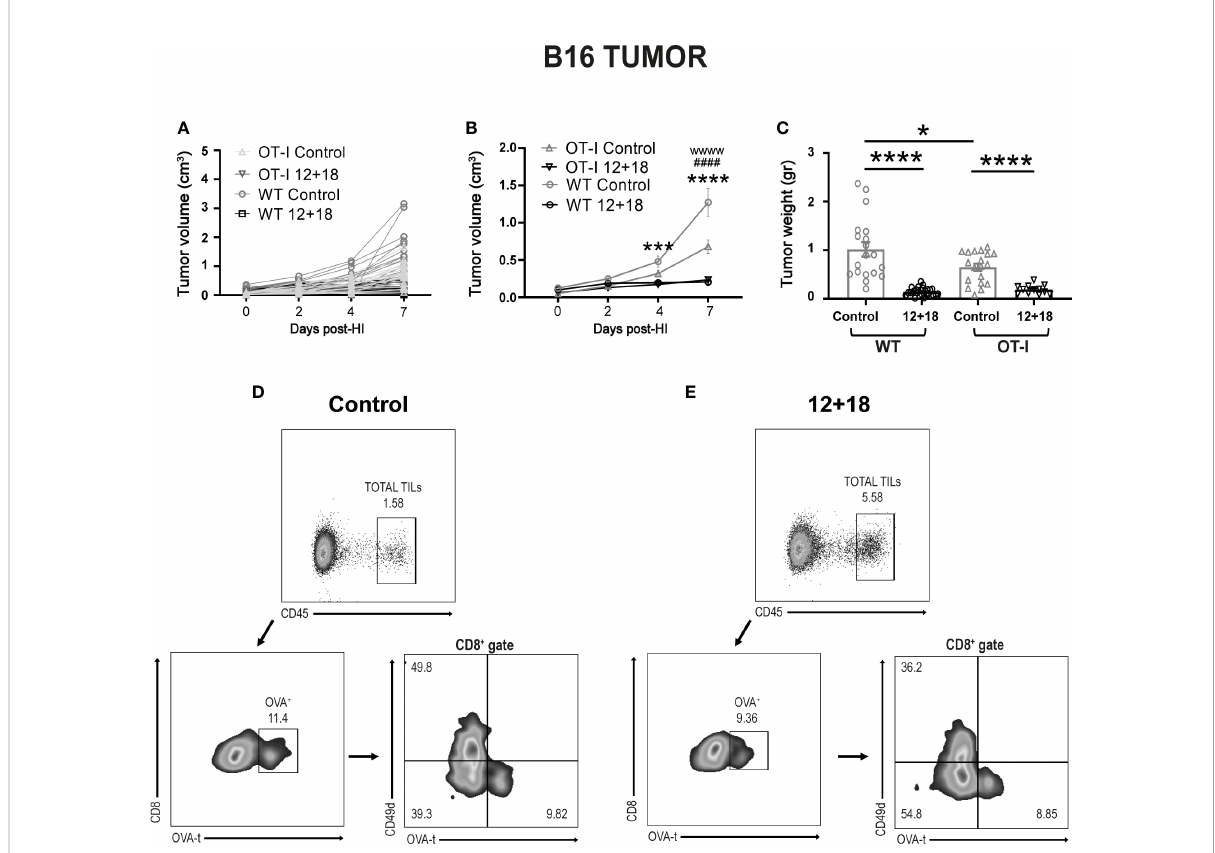
FIGURE 7 Effects of the systemic co-expression of IL-12 plus IL-18 on tumor growth on OT-I mice. OVA neg B16- bearing C57BL/6 WT and OT-I mice were hydrodynamically injected (HI) with IL-12 plus IL-18 cDNA (12 + 18) or empty cDNA as the control. At the indicated times post-HI tumor size was measured using a caliper. After 7 days post-HI mice were euthanized, and tumors were harvested and weighed using an analytical scale. (A, B) B16 Tumor growth represented as tumor volume (in cm 3 ) at speci fi ed days post-HI is shown (A) for each mouse individually or (B) as an average (mean ± SEM) for each experimental group. (C) B16 tumor weight in grams is represented as mean ± SEM for each speci fi ed experimental group. (D, E) B16 tumors from (D) control or (E) 12 + 18-treated OT-I mice were processed and stained for fl ow cytometry using Zombie dye, anti-CD45, anti-CD8, anti-CD49d and OVA-tetramer. Dot plots represent the gating strategy used for analyzing the tumor in fi ltration of CD8+ OVA+ cells from one representative animal from each group. Statistical analysis was performed using a two-way ANOVA with Sidak ’ s multiple comparison test on (B) or a One-way ANOVA test (C) . Values of *p<0.05, ***p<0.001, ****p<0.0001 were consider signi fi cant. Values of ***, ****, wwww p<0.0001 y #### p<0.0001 on (B) represent the signi fi cant difference between control and 12 + 18 WT mice (*), control and 12 + 18 OT-I mice (w) or between WT and OT-I control mice ( # )